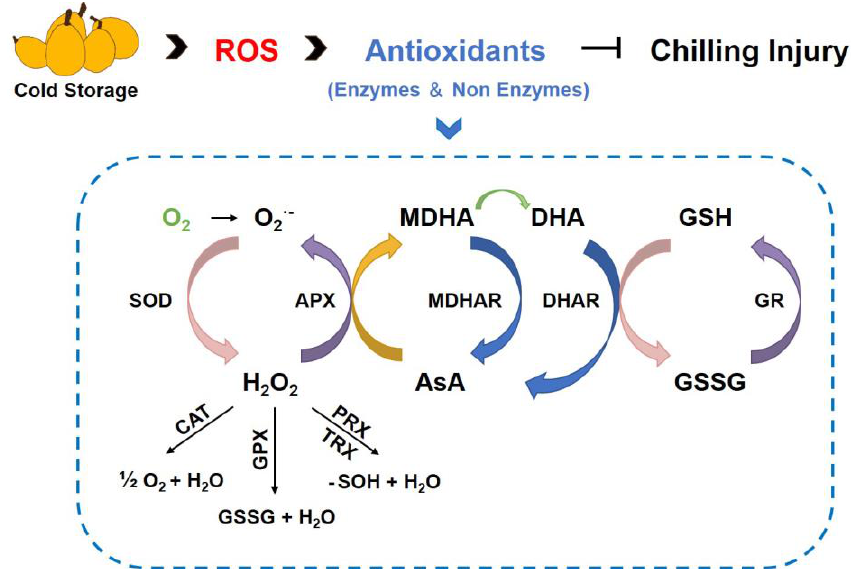
Figure 1. The antioxidant system involved in the control of ROS during cold storage of loquat. SOD, superoxide dismutase; CAT, catalase; APX, ascorbate peroxidase; GPX, glutathione peroxidase; PRX, peroxiredoxin; TRX, thioredoxin; MDHA, monodehydroascorbate reductase; MDHAR, dehydroascorbate reductase; DHA, dehydroascorbate; DHAR, dehydroascorbate reductase; GR, glutathione reductase; GSH, reduced glutathione; GSSG, oxidized glutathione; AsA, ascorbic acid.